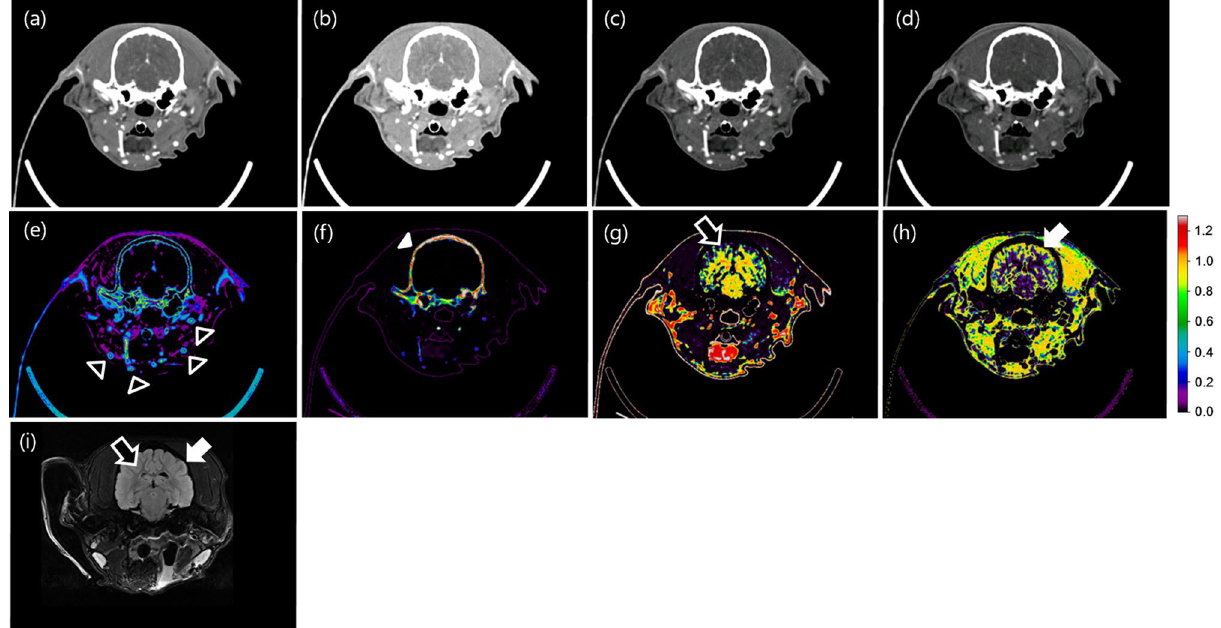
Figure 6. Contrast-enhanced axial images of the canine brain acquired at ( a ) energy levels in the range of 30 to 140 keV in the PCD CT system and ( b ) multi-energy bin 1: 30–50 keV, ( c ) bin 2: 50–65 keV, and ( d ) bin 3: 65–140 keV (CT dose index (CTDI vol ): 41.7 mGy, display window: W/L = 450/100 HU, slice thickness: 2.5 mm). An image of iodine ( e ), calcium ( f ), white matter ( g ), and gray matter ( h ) separated with the use of images of the three energy levels (bins 1, 2, and 3). Axial brain MRI ( i ) of FLAIR sequence. Black arrowheads indicate arteries, the white arrowhead indicates the skull, the black arrow indicates white matter, and the white arrow indicates gray